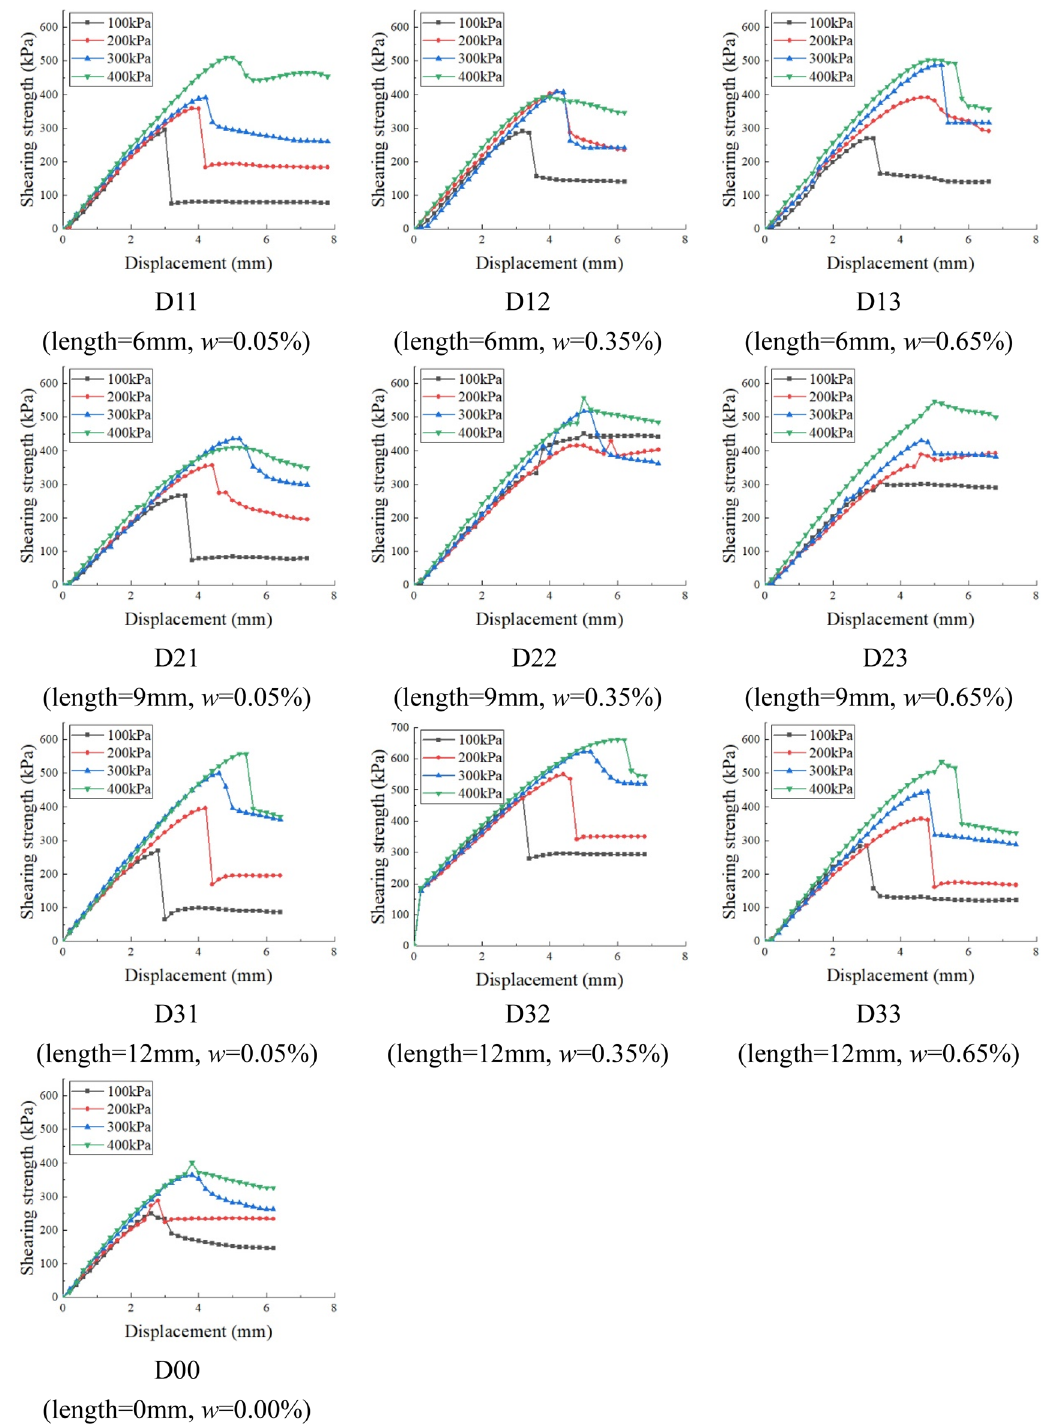
Figure 11. The shearing strength-displacement curves under different normal